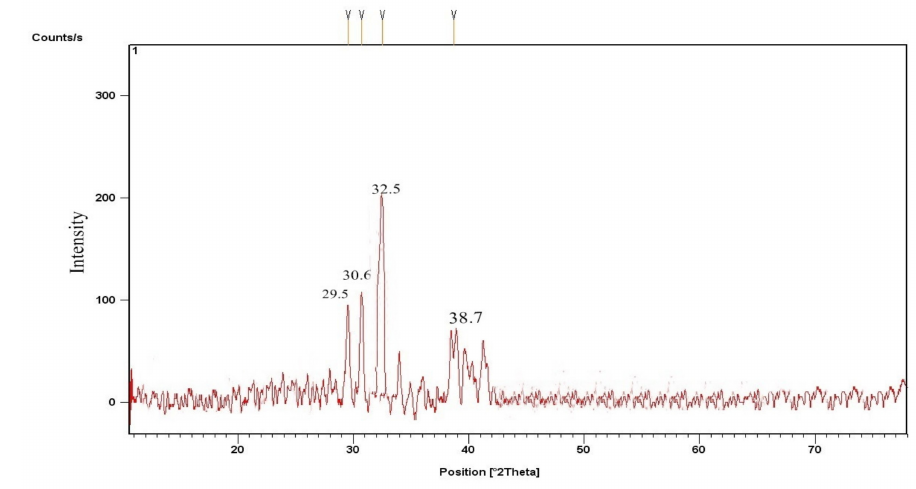
Figure 4. XRD results of KPC nano-catalyst.